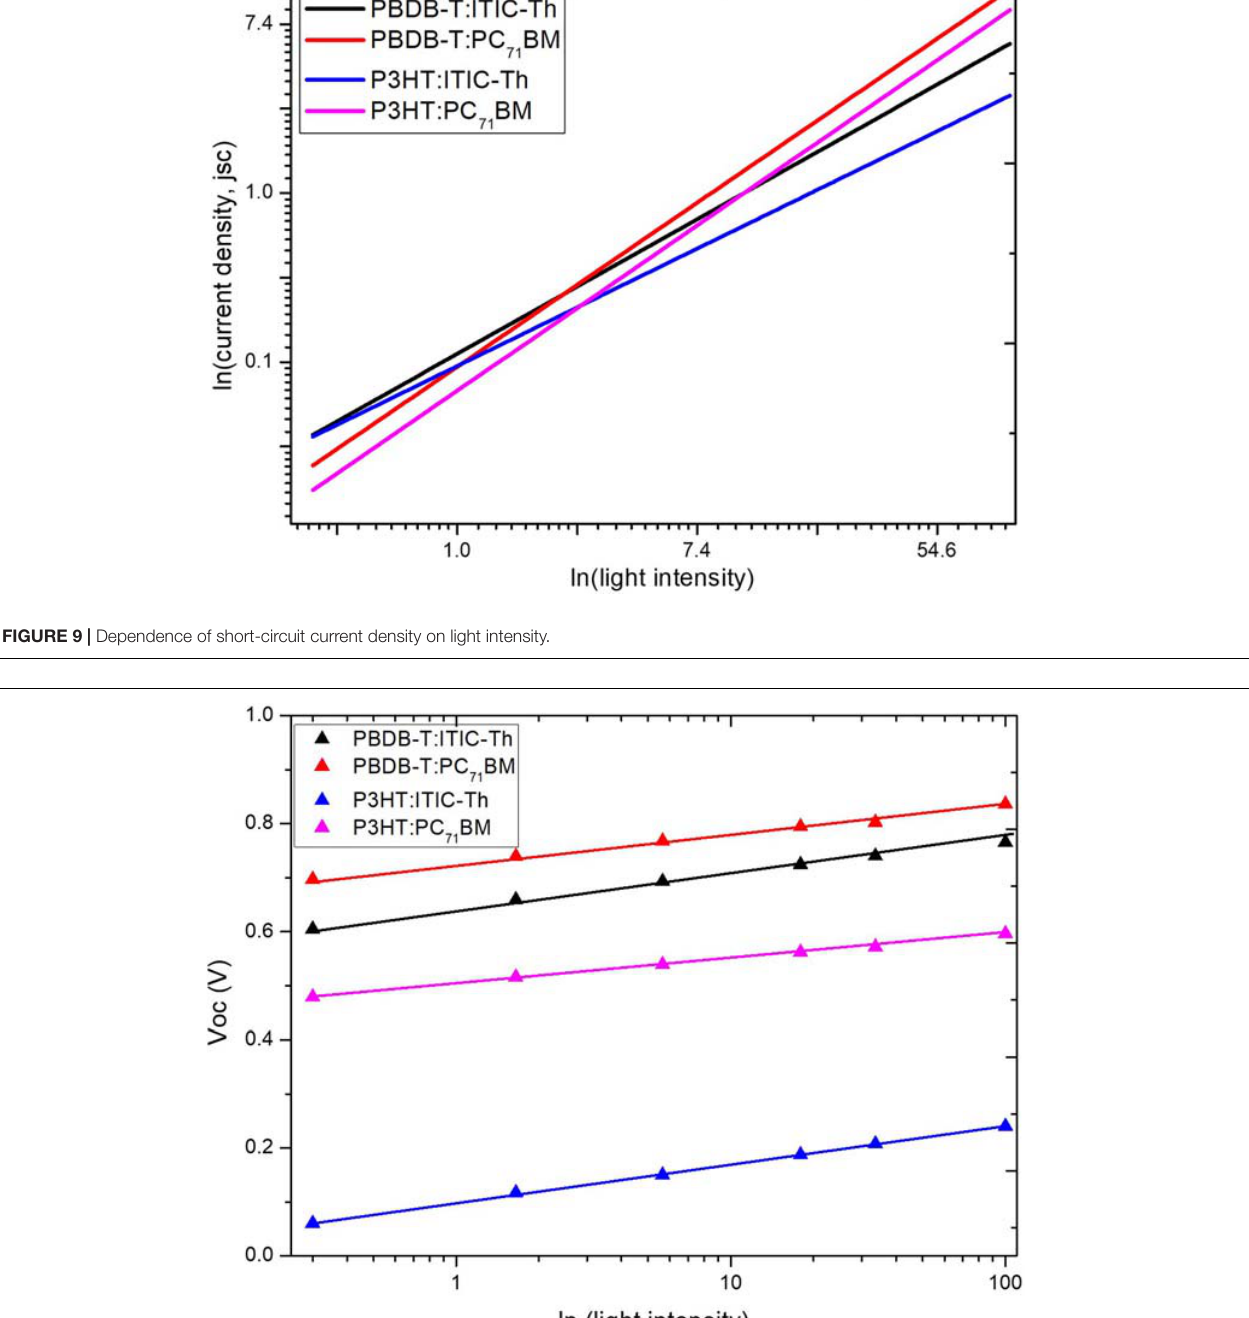
of varied intensity of light governed by the relationship Voc ∝ ( n k B T/q)log(P light ), where n represents the ideality factor, Boltzmann’s constant is shown as k B , T stand for temperature in Kelvin, and elementary charge is represented as q . The gradient of V oc against ln(P light ) is shown to estimate